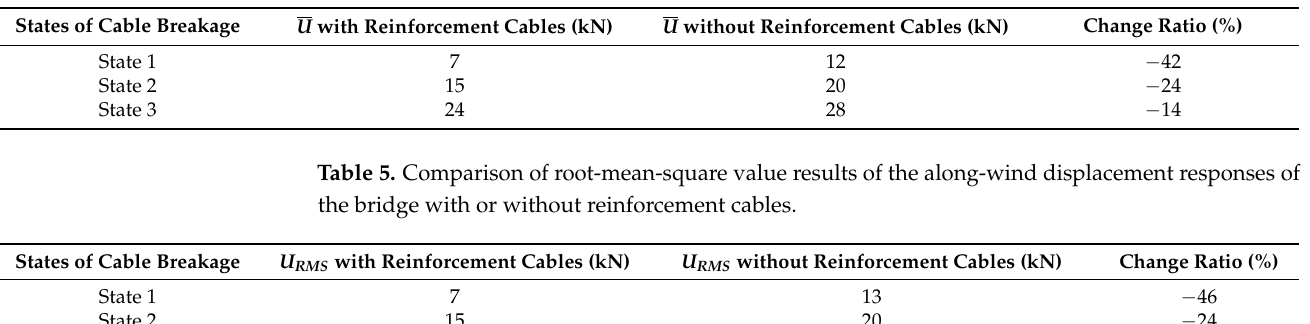
Table 4. Comparison of the mean along-wind displacement response of the bridge with or without reinforcement cables.